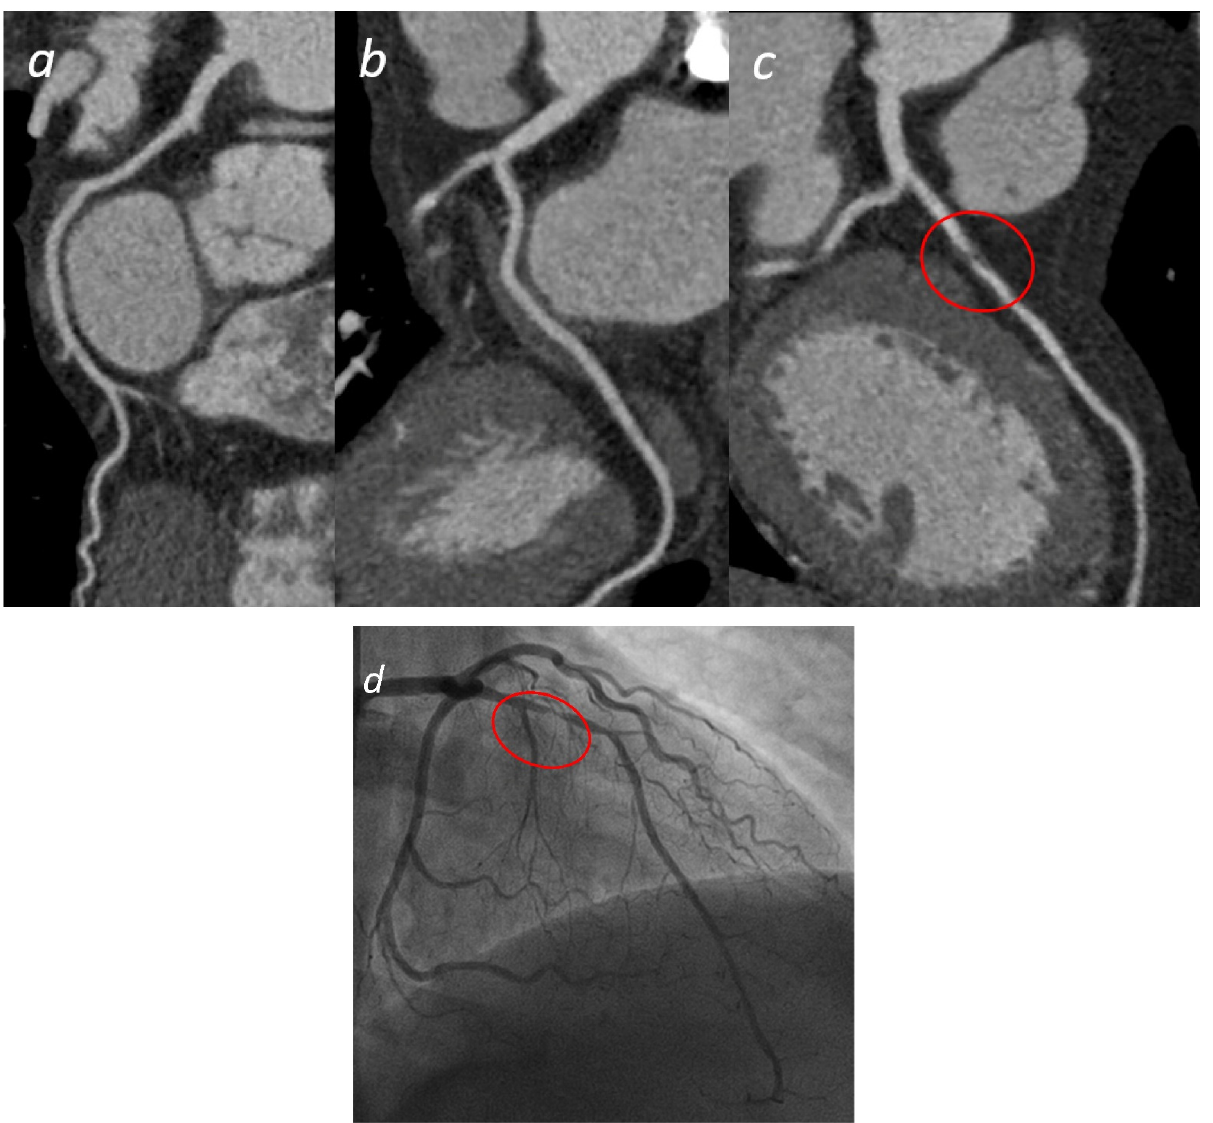
Figure 5. Acute Coronary Syndrome. A patient presenting to the emergency department with acute chest pain. No significant cardiac enzyme elevation and ECG alteration. Cardiac CTA shows absence of significant stenoses in the right coronary artery ( a ) and the left circumflex ( b ); a significant stenosis in the proximal anterior descending artery ( c ) is present, confirmed by subsequent coronary angiogram ( d ).